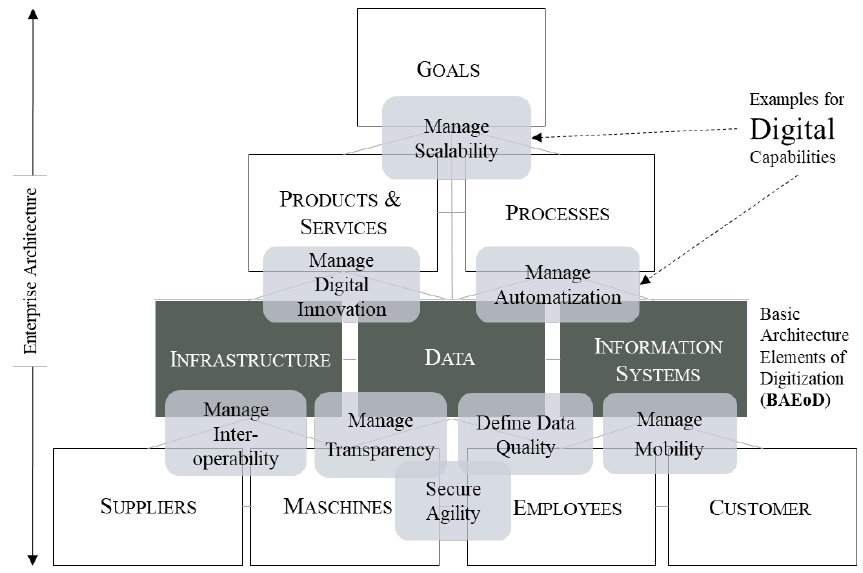
Figure 2. Reference Enterprise Architecture Approach for zoo gardening facilities, based on [10] Each element represents a structural feature of the enterprise, which is characterized by different properties and relations. The elements infrastructure, information systems and data are present in every enterprise architecture and are characterized by their technology-based composition and their dependency on many other elements within the company. They are the basic architecture elements of digitization (BAEoD) , which are visualized by Figure 2. Since the digital progress can take place in many areas of a company (multi-perspective approach), these BAEoD inevitably have to be combined with other elements through horizontal and vertical integration [29]. With the resulting “digital capabilities”, it is possible to work with zoo-gardening institutions to encounter the deliberation: “What digitization actually means for the respective institution” (Section 5). In conclusion, the development of EA , regardless of the kind of enterprise, requires the analysis and consideration of various stakeholders, which in turn is a fundamental part of the management of an enterprise architecture